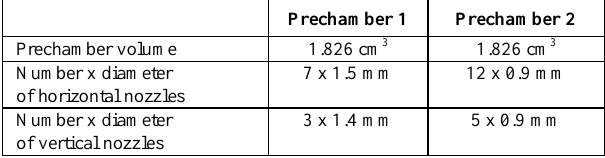
Fig. 5. Used prechambers (jet exit sides) Table 2. Main characteristics of the prechambers compared in this study